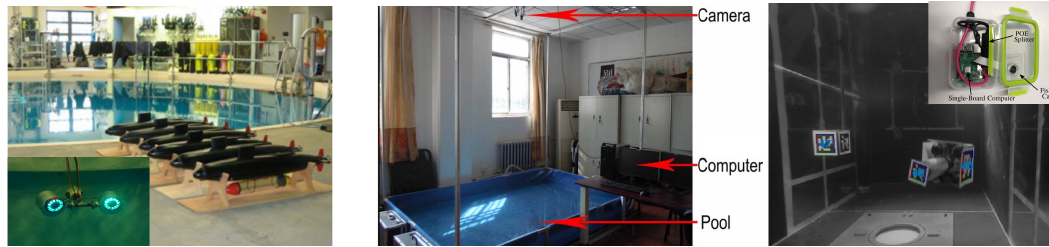
Figure 6. Example works external camera systems for underwater localisation, SCUUL multi-camera testbed [97] ( left ), Single-topdown camera [98] ( center ), low-cost multi-camera system [95] ( right